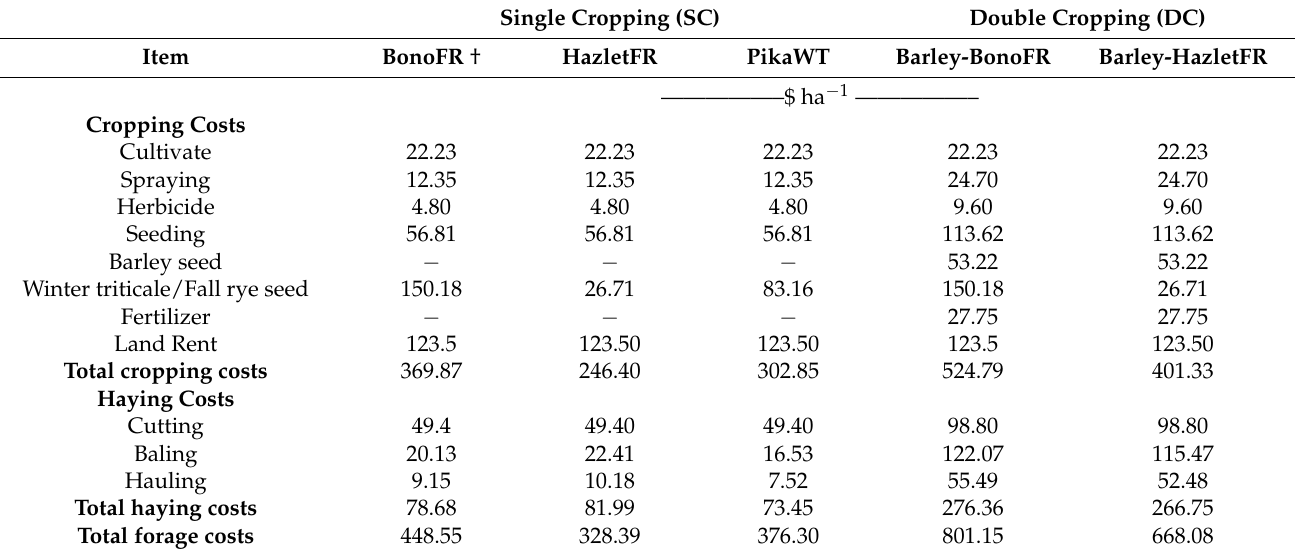
Table 9. Forage production costs of winter cereals in single and double cropping systems over 2 years.